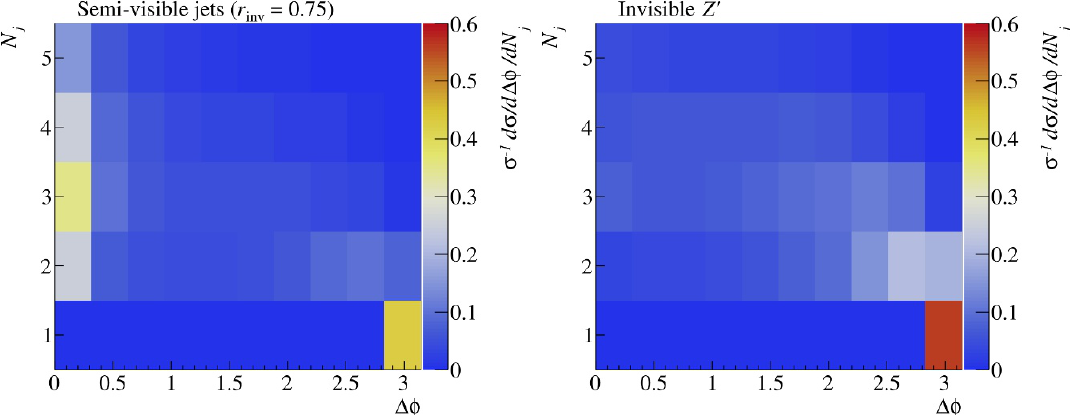
Figure 4 . Double di(cid:11)erential cross section with respect to (cid:1) (cid:30) and N j for the dark sector model (left) and a fully invisible Z (right) with m Z 0 = 1 TeV. For both panels, the typical mono-jet 0 requirement =E 250 GeV has been T >